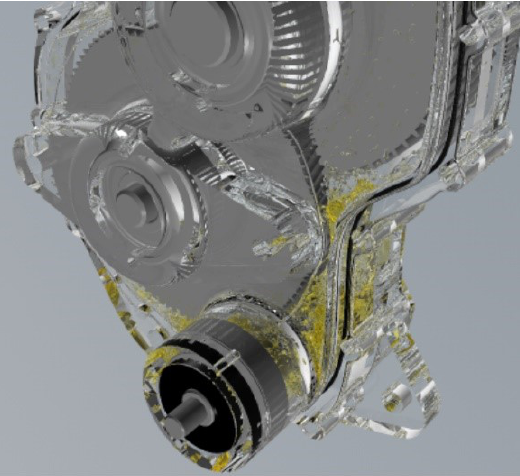
Figure 19. Analysis of the splash lubrication system by using the software PreonLab. The resulting drive system with its components can be seen in Figure 20.